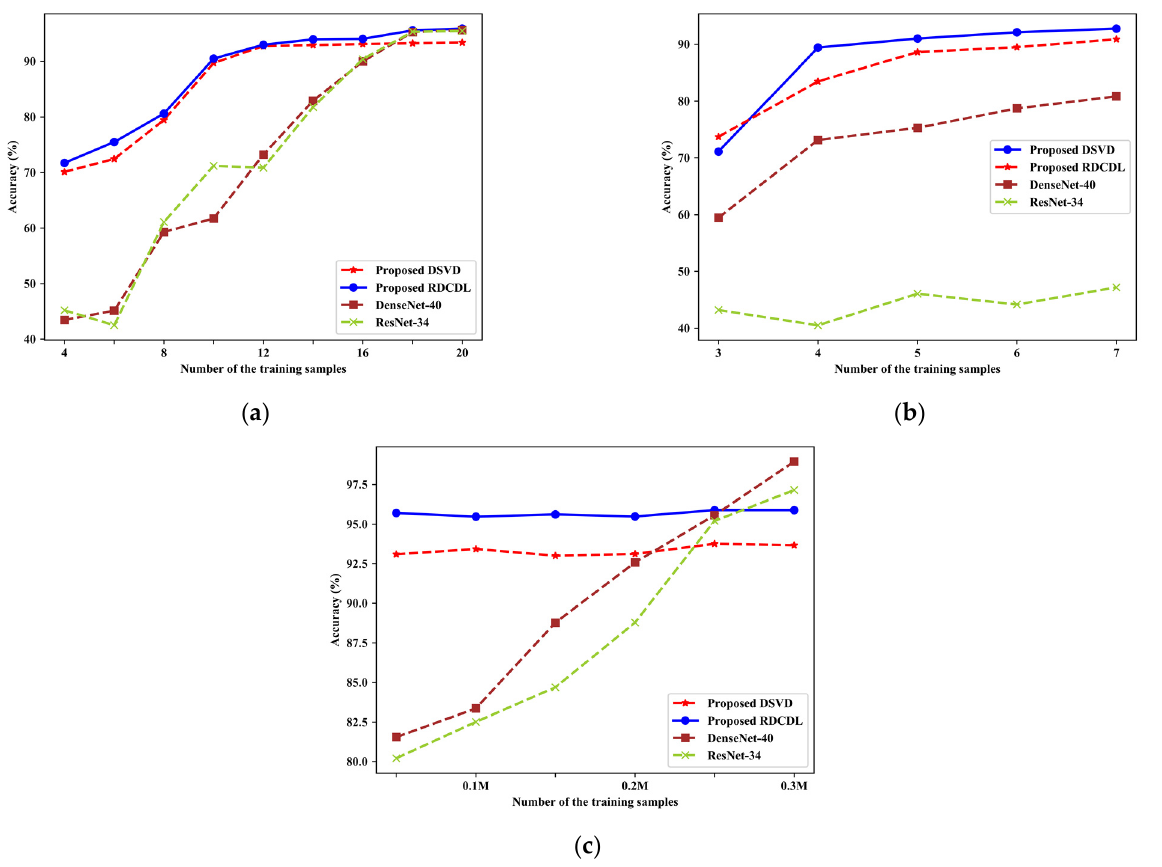
Figure 10. ( a ) The average performance of different training samples on the Extended Yale B database; ( b ) The average performance of different training samples on the AR database; ( c ) The average performance of different training samples on the CASIA-WebFace dataset.